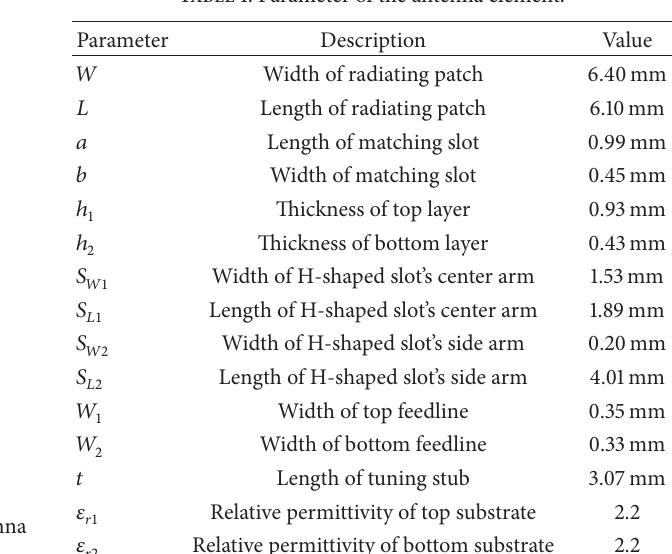
Table 1: Parameter of the antenna